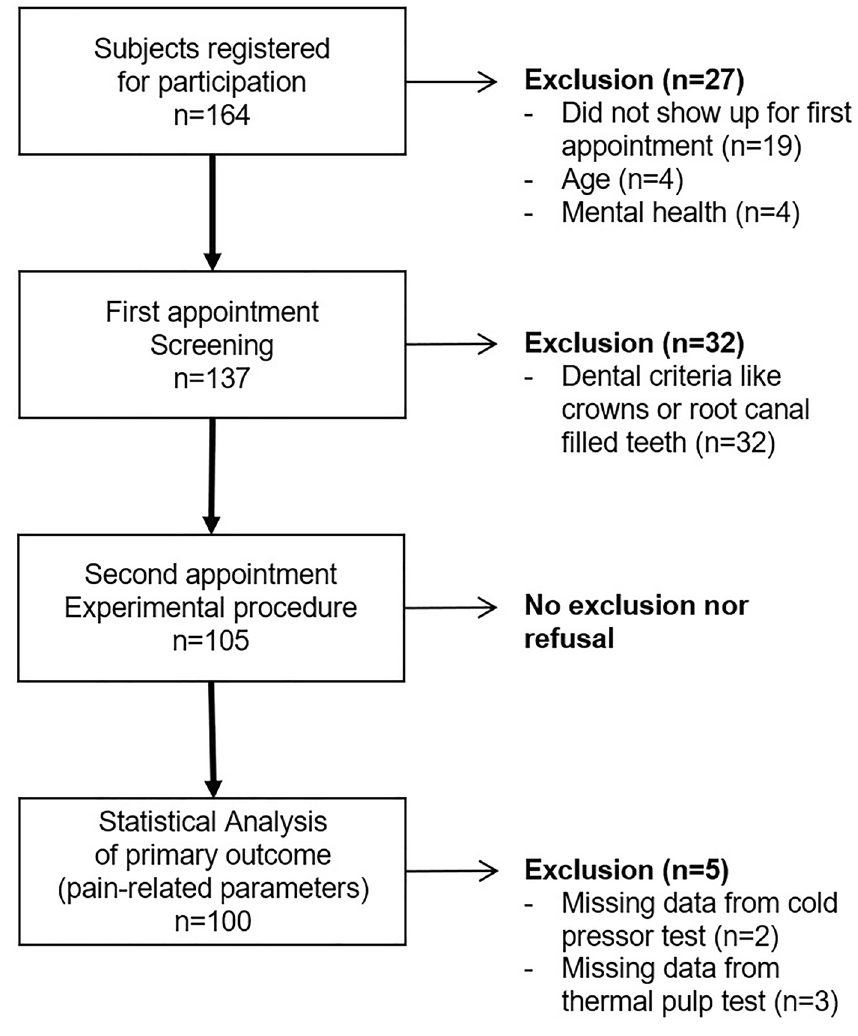
Figure 1. Flow-chart of the sample composition.